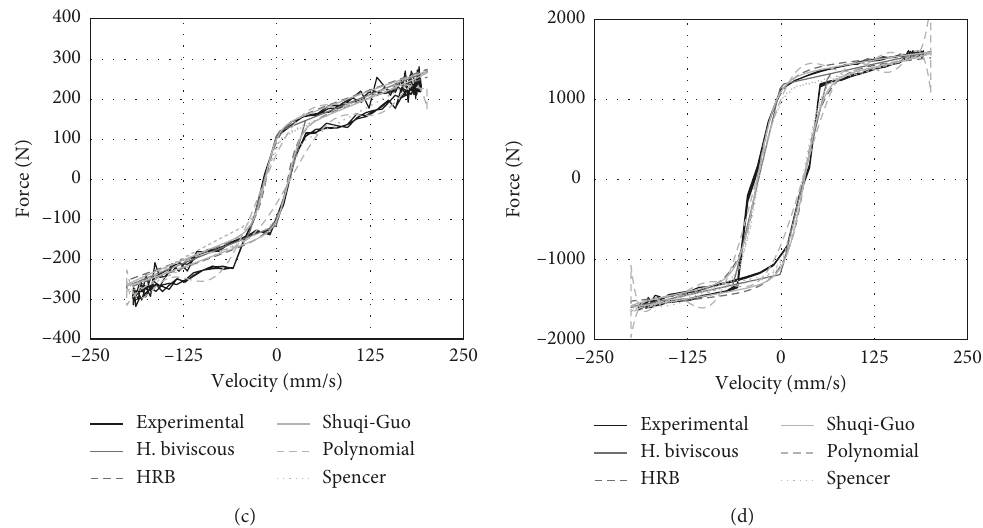
Figure 6: Hysteretic model predictions for four different experimental tests: (a) low velocity without intensity; (b) low velocity with I (c) high velocity without intensity; (d) high velocity with I